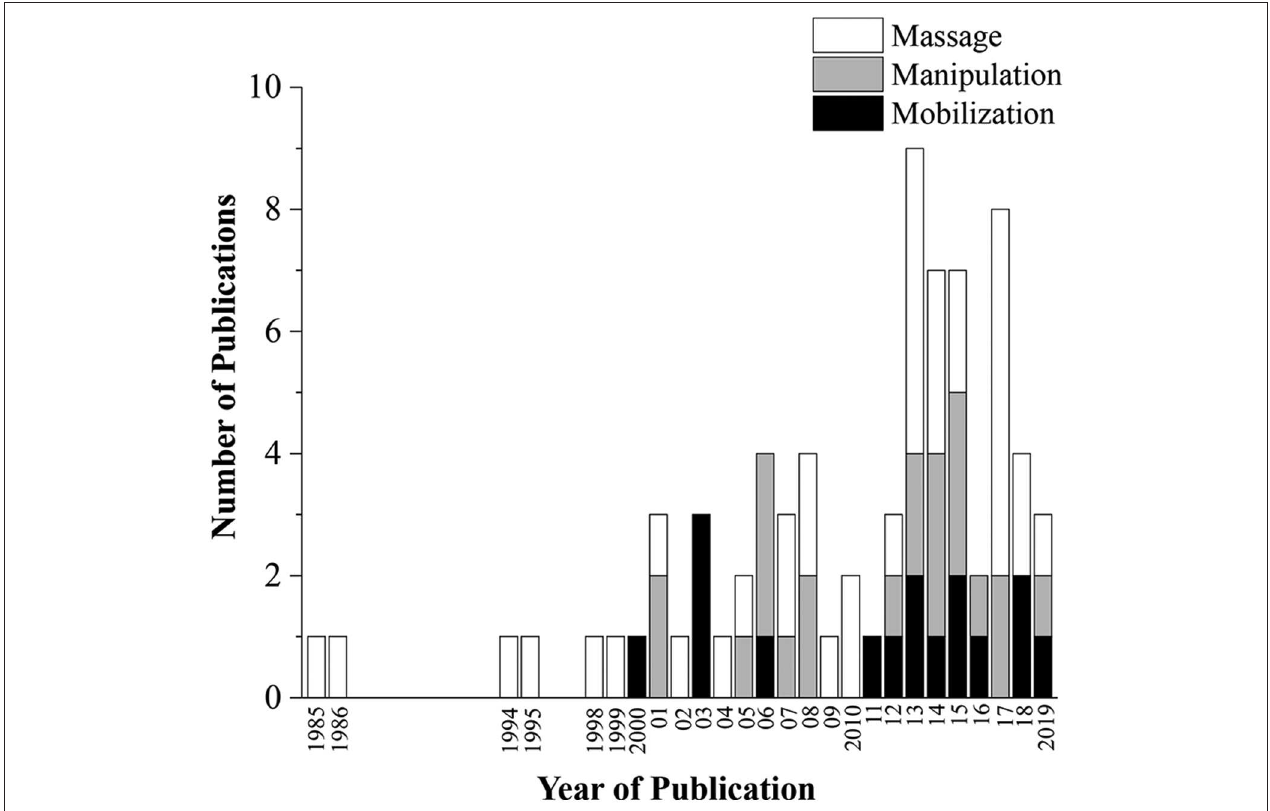
FIGURE 2 | Number of publications per year. Hybrid studies not included.